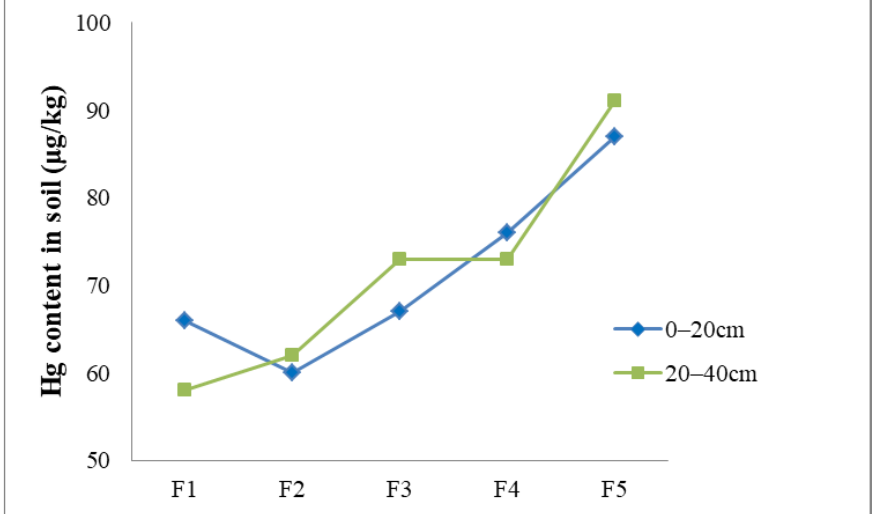
Figure 3. Hg content in different soil size fractions. F1 =< 2000~850 µm; F2 =< 850~250 µm; F3 =< 250~125 µm; F4 =< 125~63 µm; F5 =< 63 µm.